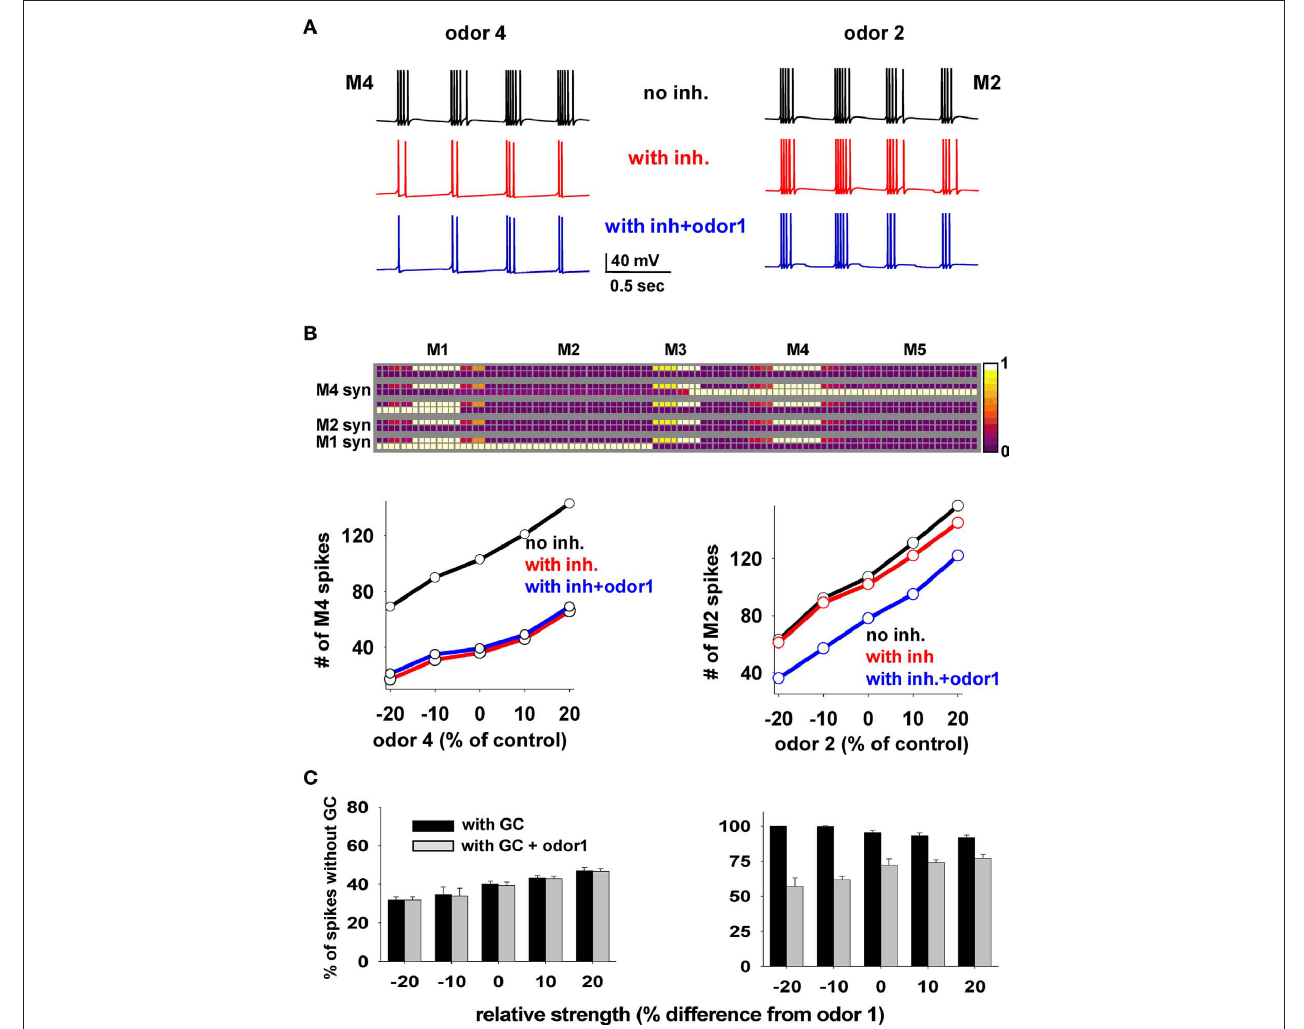
presentation of different odor combinations as a function of odors 4 or 2 strength, respectively; in all cases control strength is the input used in the simulation for Figure 3 ; red lines are slightly shifted downward for full visibility. (C) Average number of spikes ( ± SD) from five simulations, for M4 ( left ) and M2 ( right ) with respect to control, as a function of relative odor strength under different